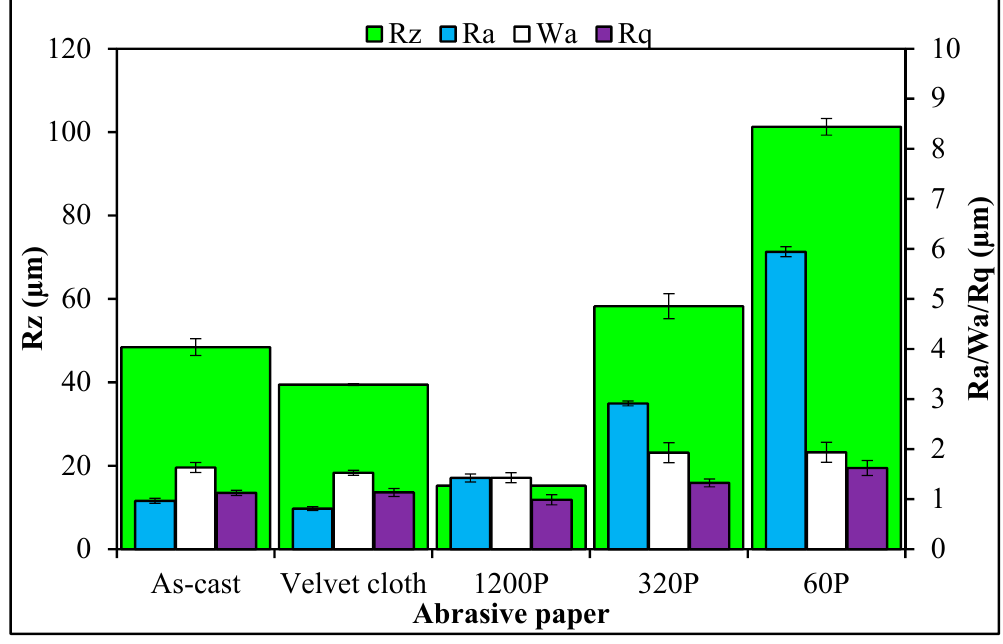
Figure 9. Topographical features of 0.1 wt % clay-EP nanocomposites. Figure 10. Topographical features of 0.1 wt % clay-EP